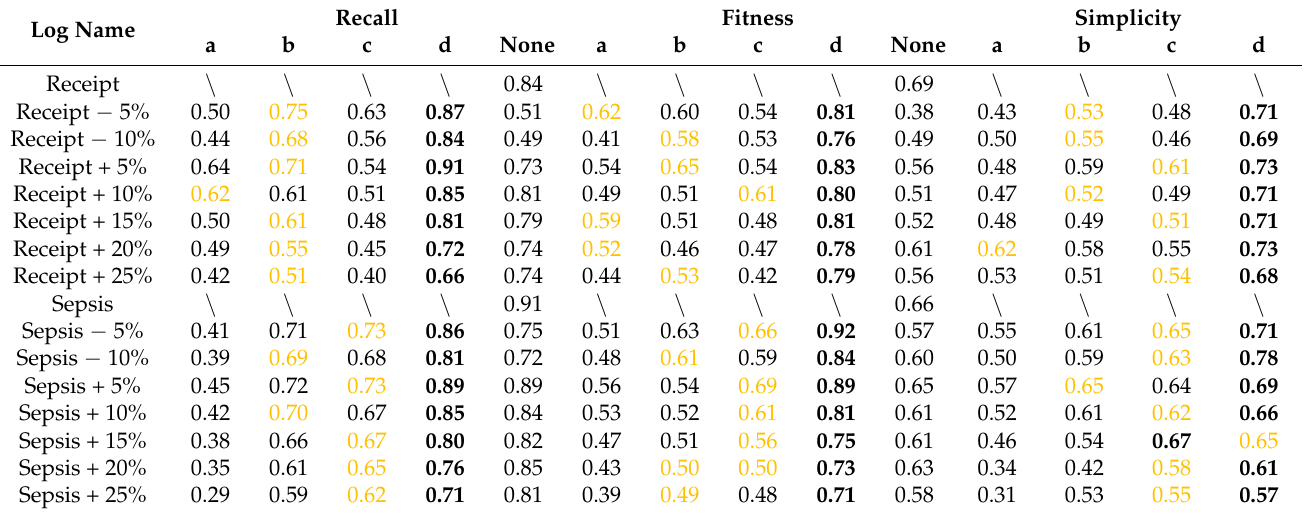
Table 2. Anomaly detection result metrics. No measures are recorded as None, and BN by Constraint- Based Learning, BN by Tree Search, BN by Hill Climb Search, and BN by Petri-based Learning are abbreviated as a,b,c,d, respectively, with the highest values marked in bold black and the second highest values in